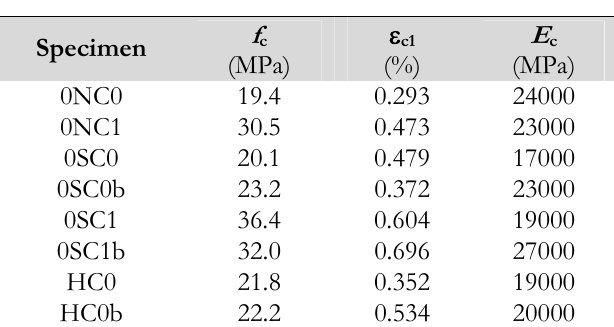
Figure 6: The stress-strain relationships of Sismabeton, NC and SC.